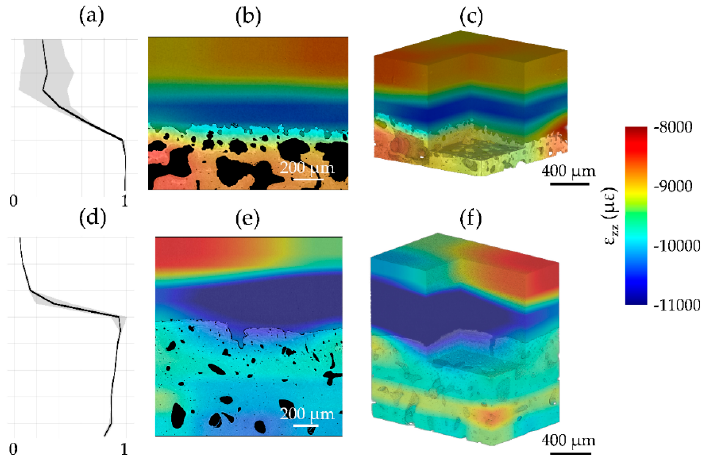
Figure 6. Correlation coefficient and full ‐ field axial strain ( ε zz ) representation in synthetic deformation test (1% strain) for ( a – c ) CB1 and ( d – f ) CB5 specimens imaged at 3× and 4× propagation ‐ based phase ‐ contrast (PC), respectively. ( a , d ) The mean correlation coefficient (black line) across all the slices and its standard deviation (gray shaded region) is shown along the cartilage ‐ bone plug length. ε zz distribution for a cross ‐ section of ( b ) CB1, ( e ) CB5 and for ( c , f ) their volumes were computed using a multipass scheme (48 voxel final sub ‐ volume size).